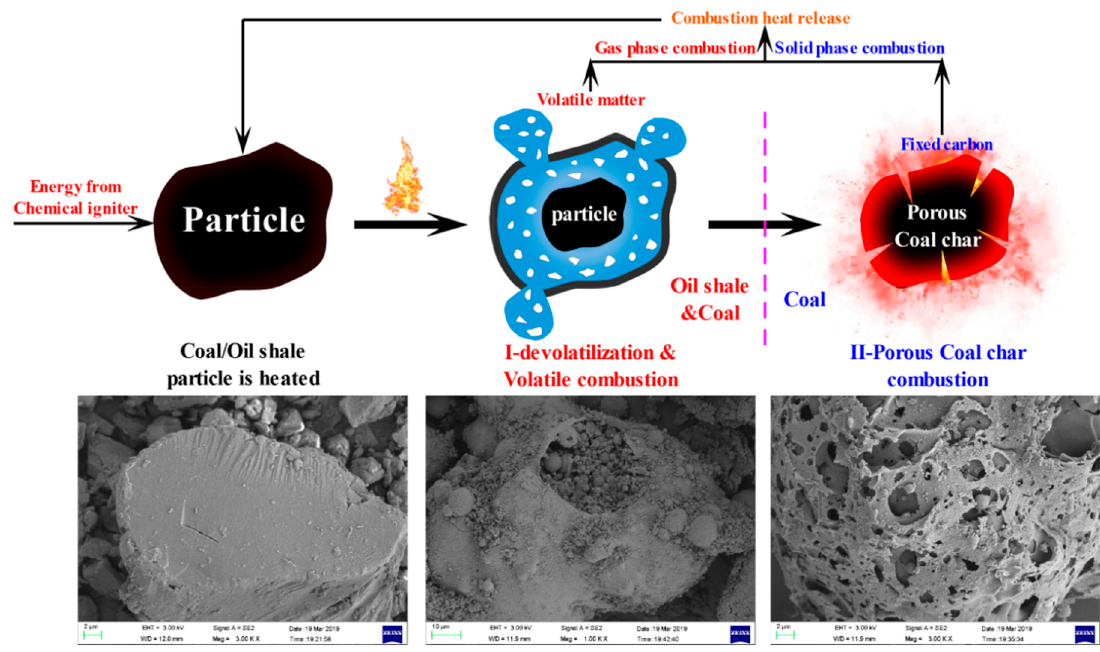
Figure 12. The explosion process and mechanism.